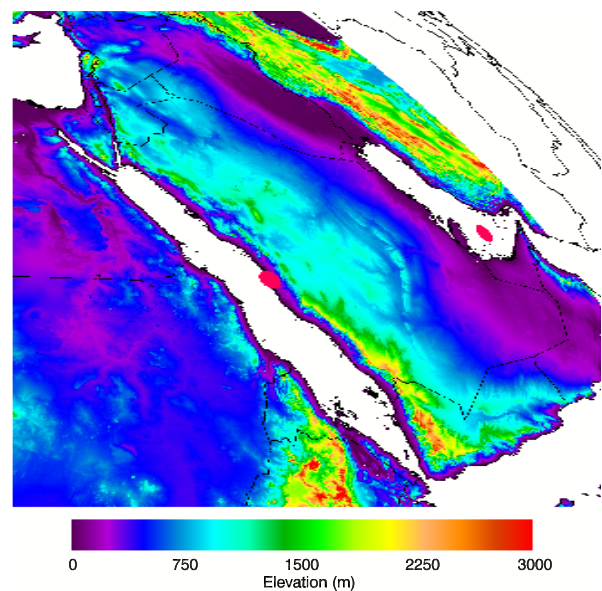
Figure 1. Map of the Middle Eastern domain of interest on the SE- VIRI projection: the KAUST AERONET site on the Red Sea coast is marked as a red spot, as is the Abu Al Bukhoosh site in the Persian Gulf. The colour contours represent the surface elevation (as devel- oped by the EUMETSAT Satellite Application Facility for Now- casting; MétéoFrance, 2013). Elevation data are truncated at the 70 ◦ viewing zenith angle contour. Note also the increasing curvature of the SEVIRI projection towards the northeast of the field of